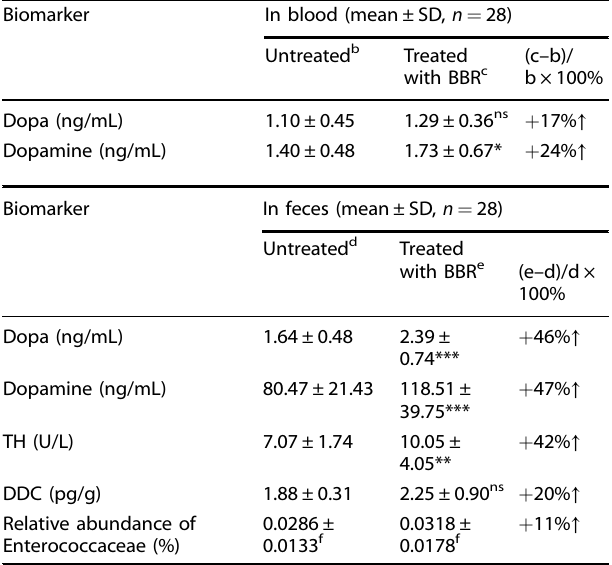
Table 1. Berberine regulated the biomarkers in blood and feces of clinical subjects a